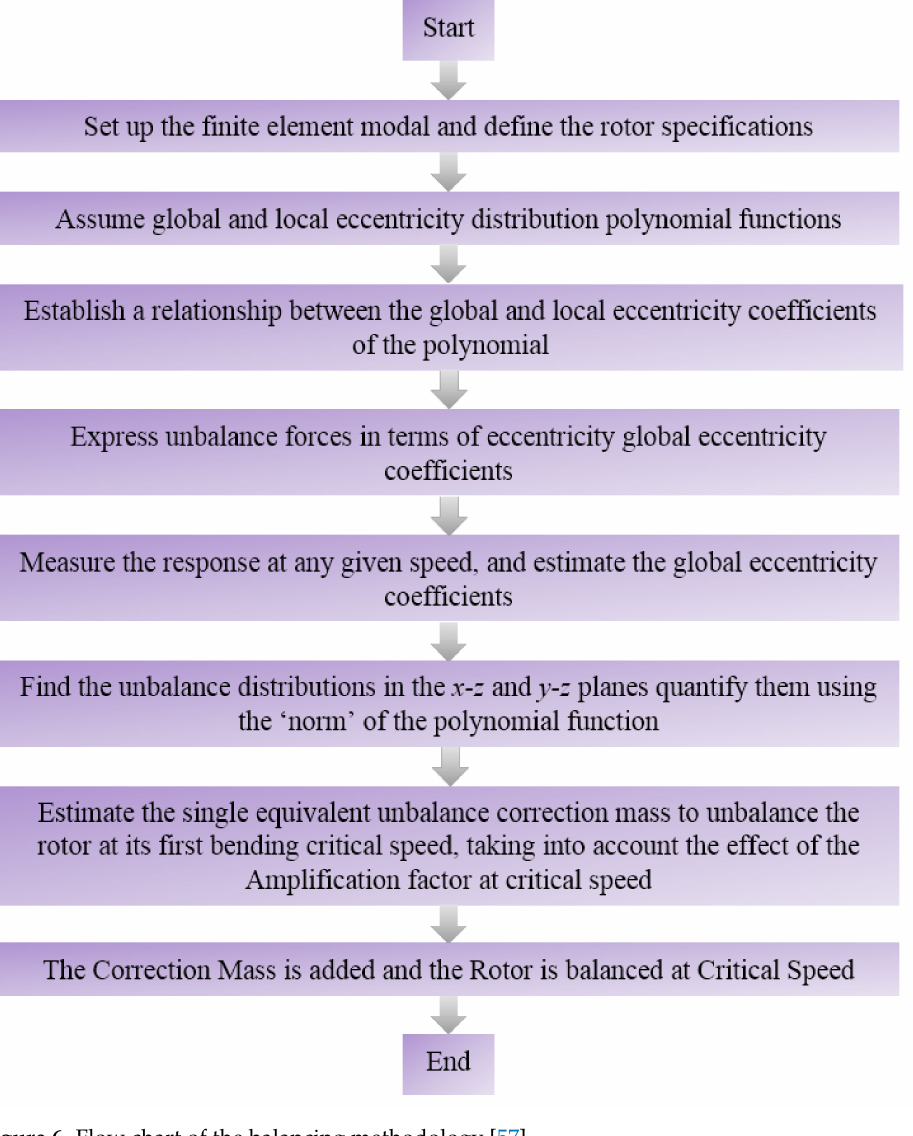
Figure 6. Flow chart of the balancing methodology